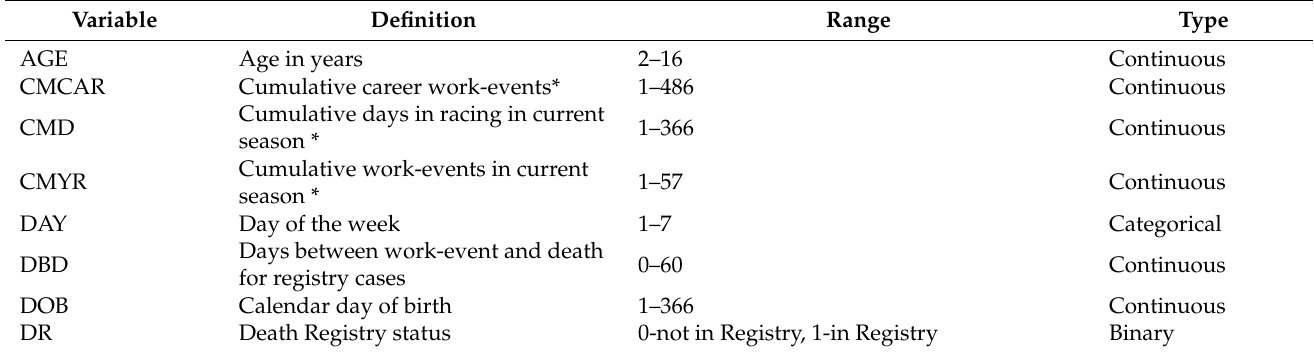
Table 2. Glossary of variables, terms, and